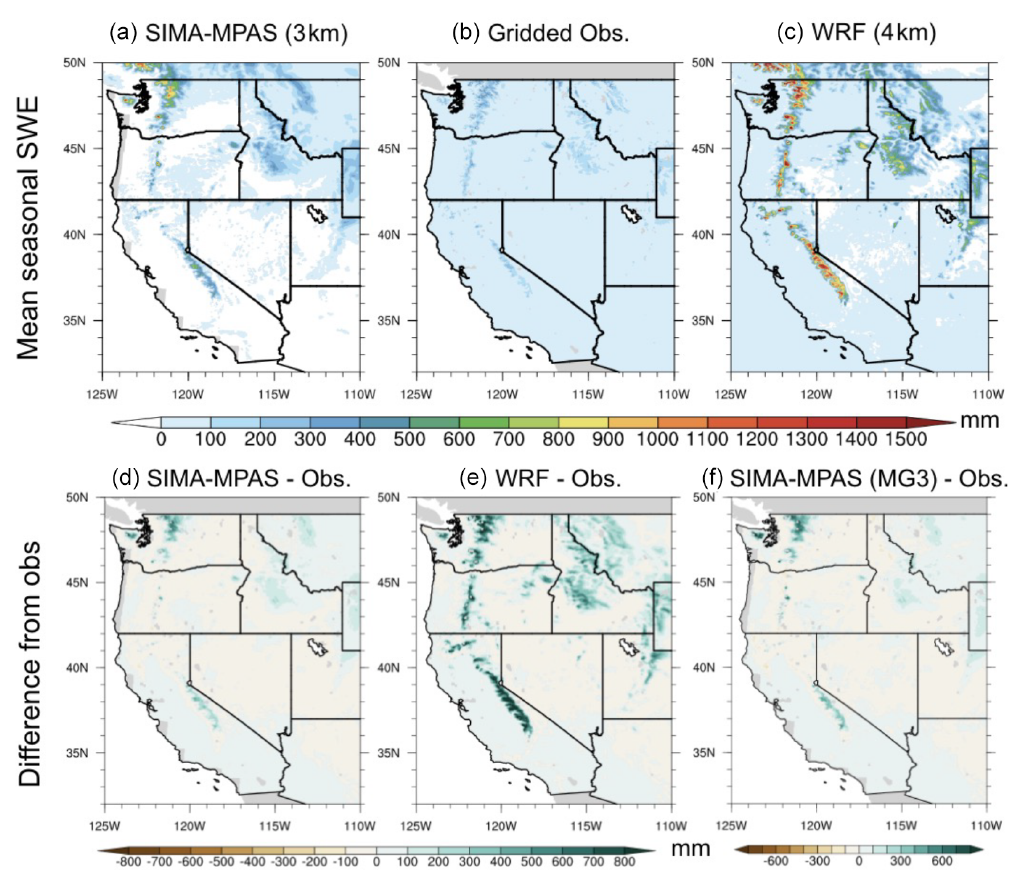
Figure 7. Wet-season snow water equivalent (SWE) over the western USA. First row: seasonal mean SWE averaged over (1999–2004) from (a) SIMA-MPAS, (b) gridded observation for SWE as described in the Sect. 2.2, and (c) WRF data; Second row (d–f) : absolute differences from observation with all data regridded to 4km for SIMA-MPAS and WRF averaged over 1999–2004 and SIMA-MPAS (MG3) averaged over 1999–2002.